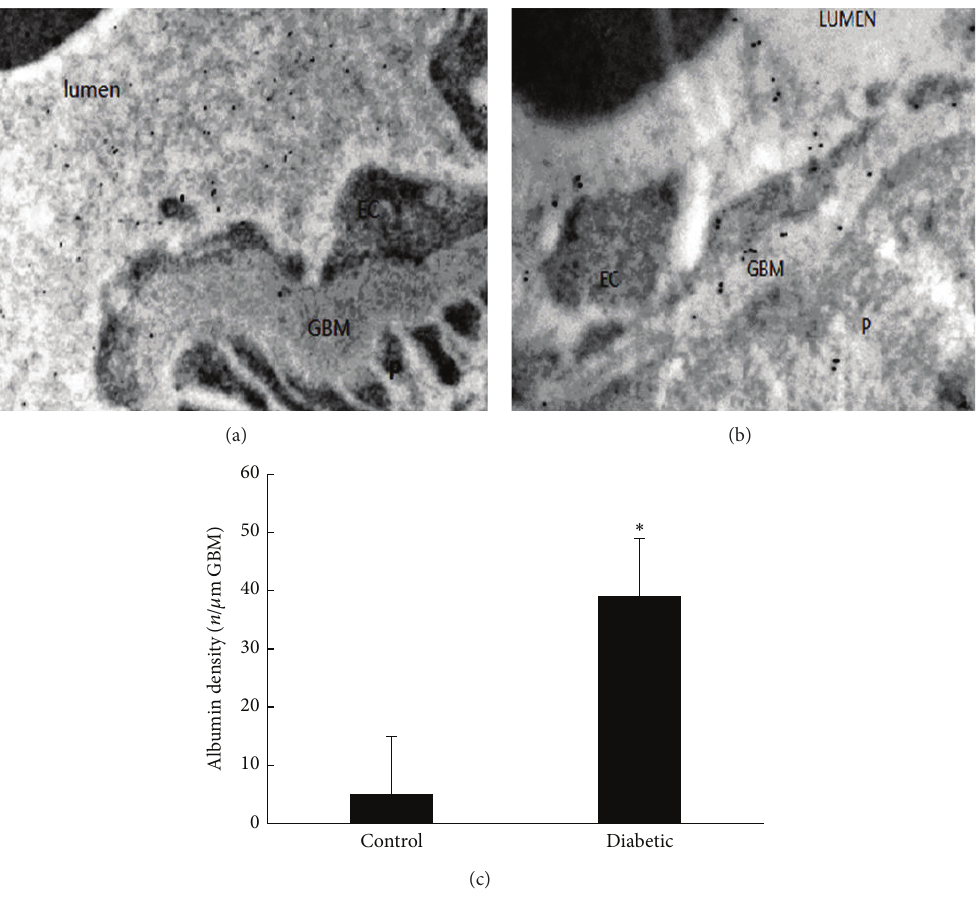
Figure 3: (a)–(c) Increased GFB permeability to albumin in diabetic rats, as revealed by postembedding immunocytochemistry. (a) Control rats; (b) diabetic rats; (c) increased albumin in the GBM of diabetic rats. ∗ 𝑃 < 0.05 versus (c).